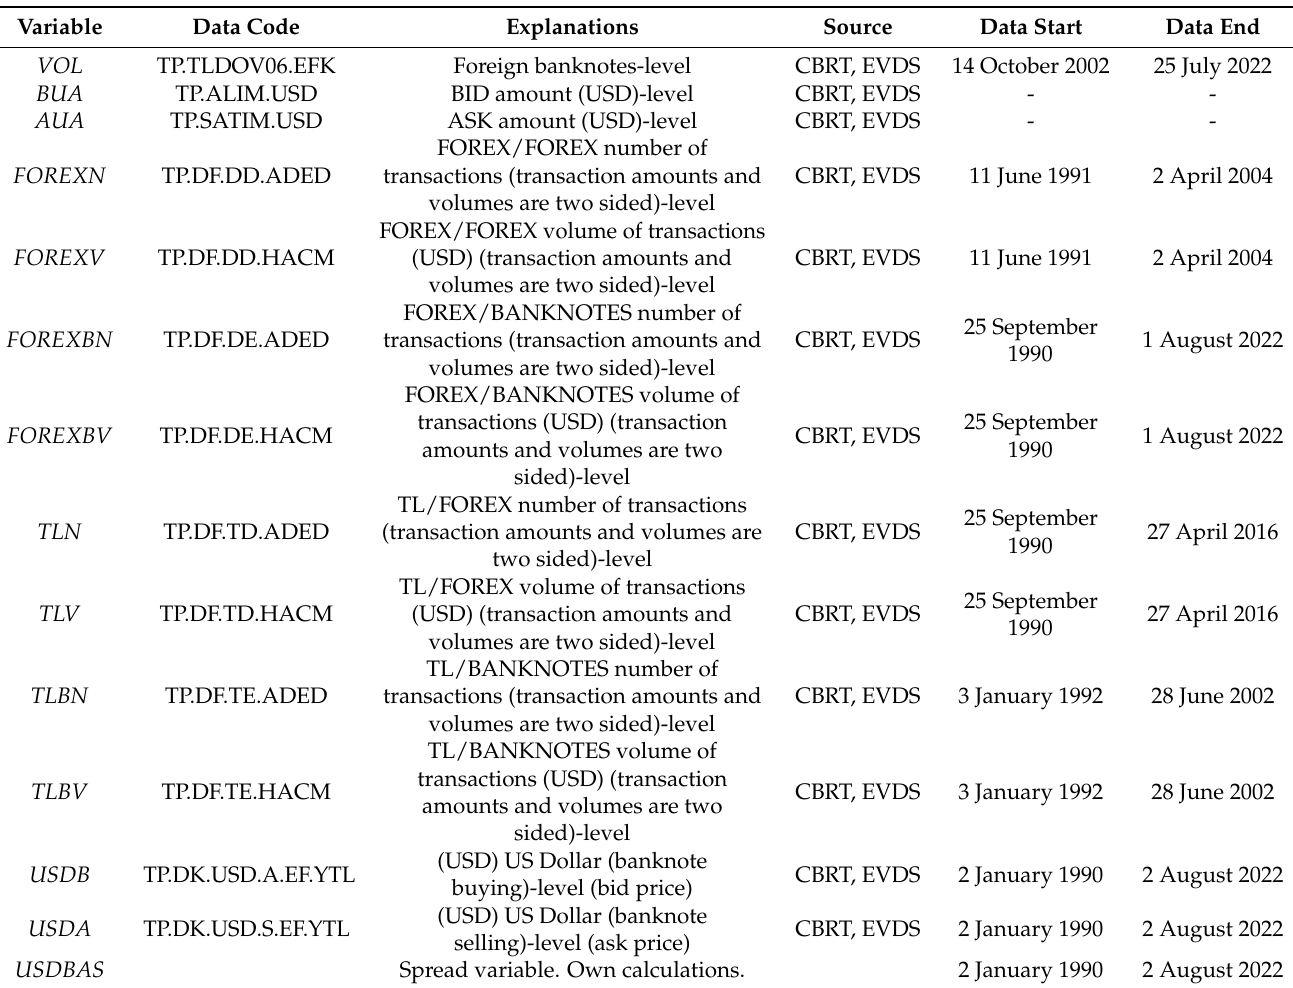
Table 1. Definition of